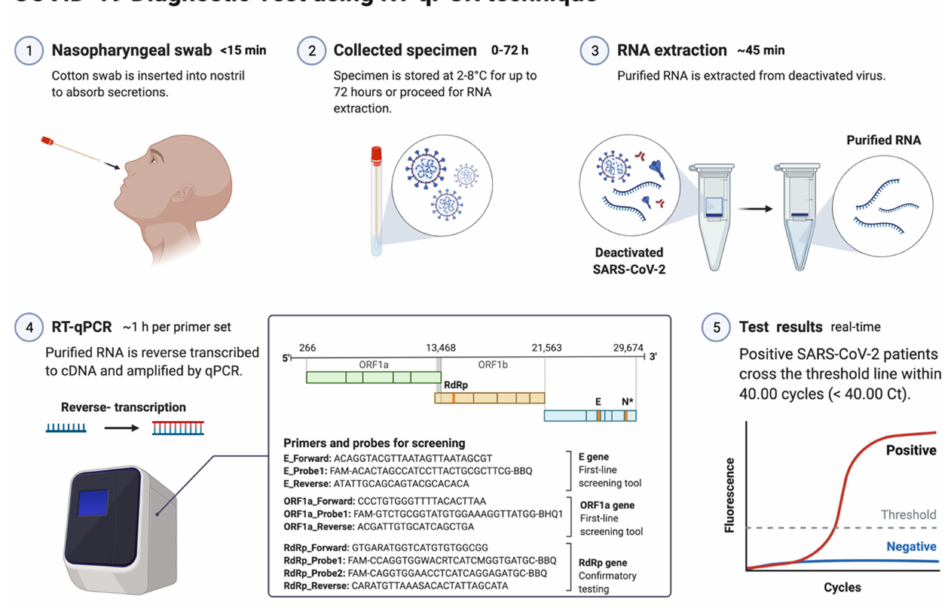
Figure 3. Schematic representation of COVID-19 diagnostic test using RT-PCR. This figure was created with Biorender.com on 18 May